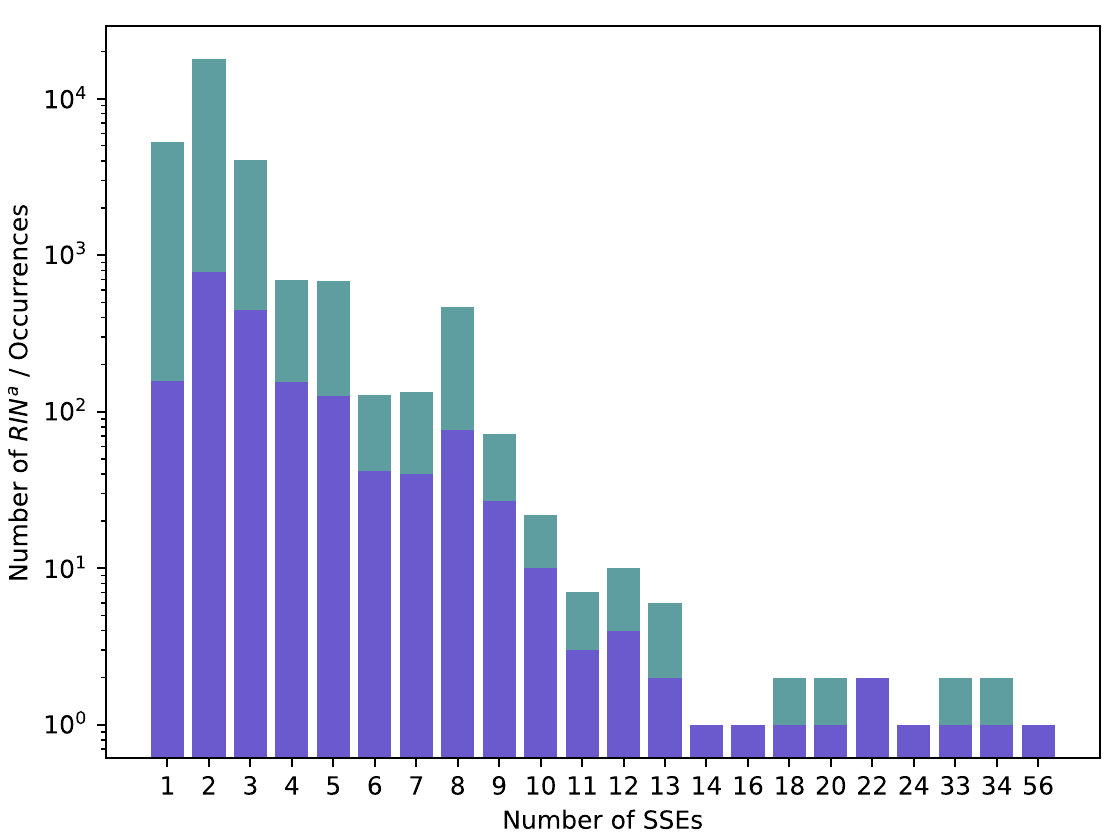
Fig 12. Distribution of RIN a in Dataset 3.137. Numbers of distinct RIN a s numbers of SSEs they span over in Dataset 3.13.